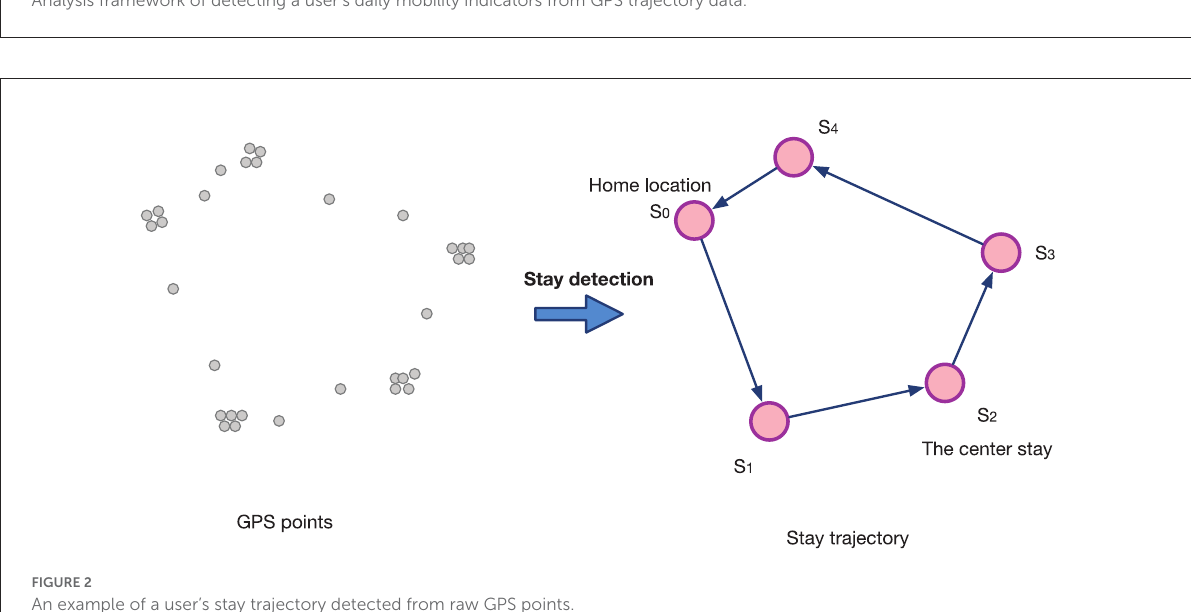
FIGURE2 An example of a user’s stay trajectory detected from raw GPS